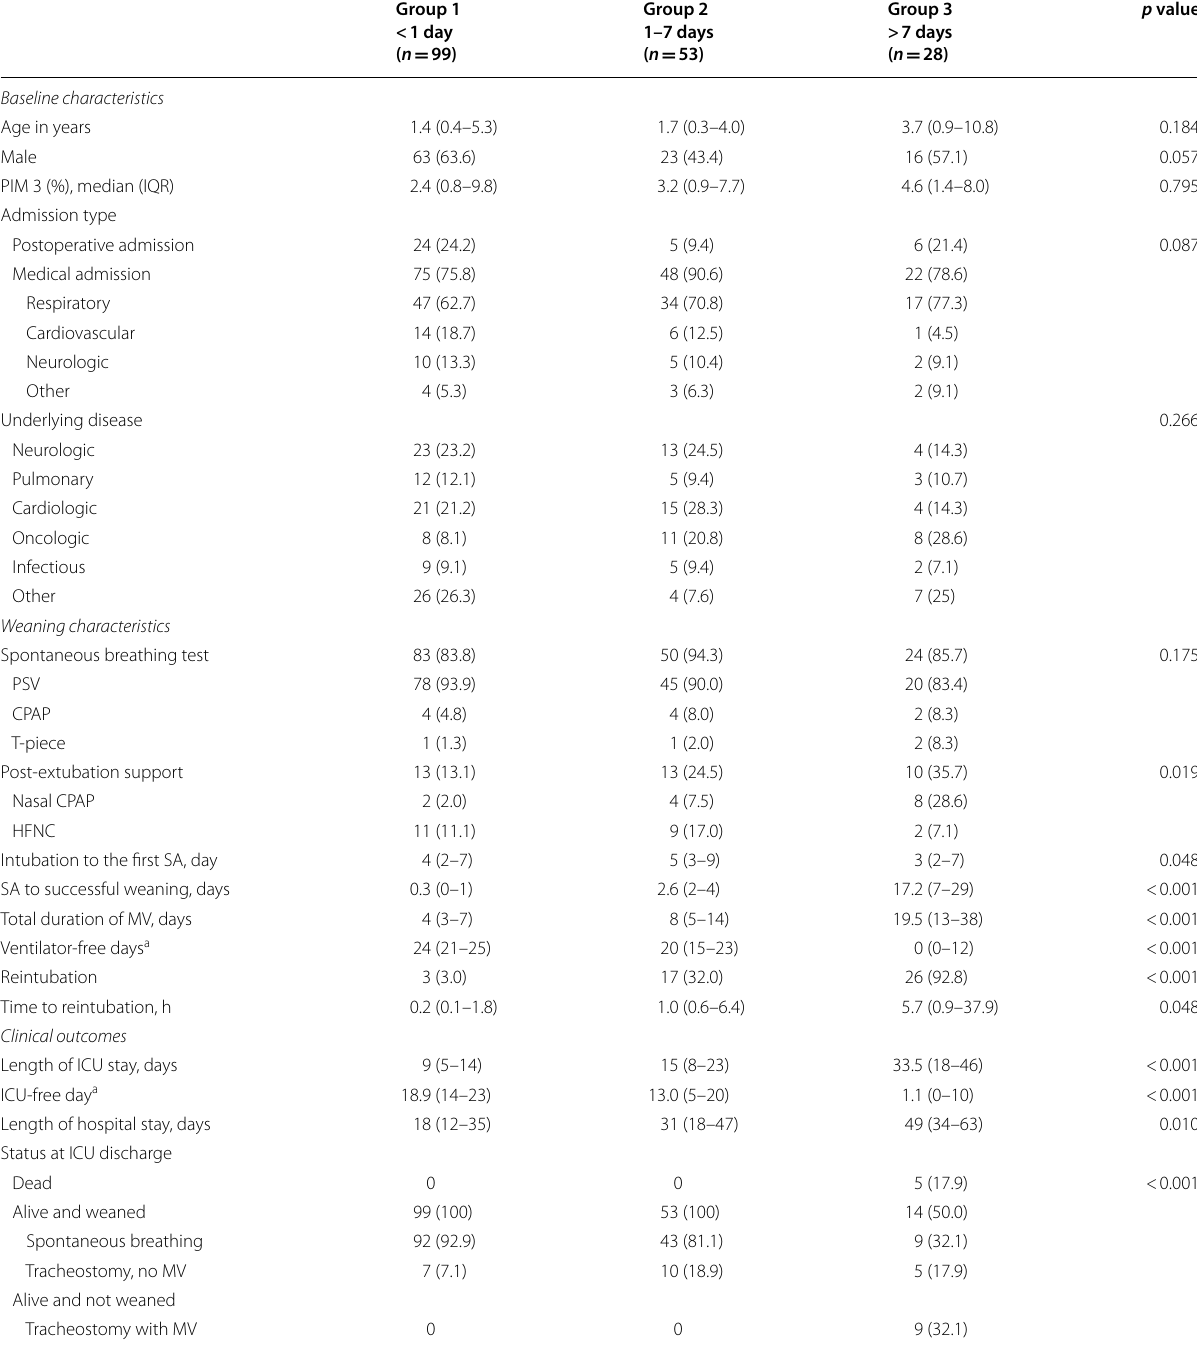
Table 2 Clinical characteristics and outcomes of patients according to weaning